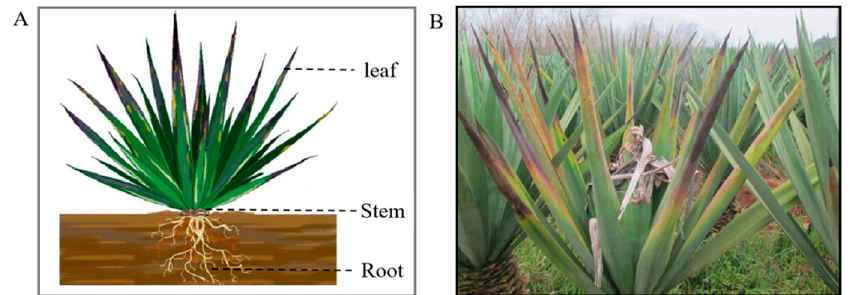
Figure 7. ( A ) Schematic diagram of the sampling parts on the sisal plants. Dotted lines indicate the sampling tissues; ( B ) sisal plants infected with PLD, showing purple margins, rolling, and yellowing of leaves accompanying central head rotting.